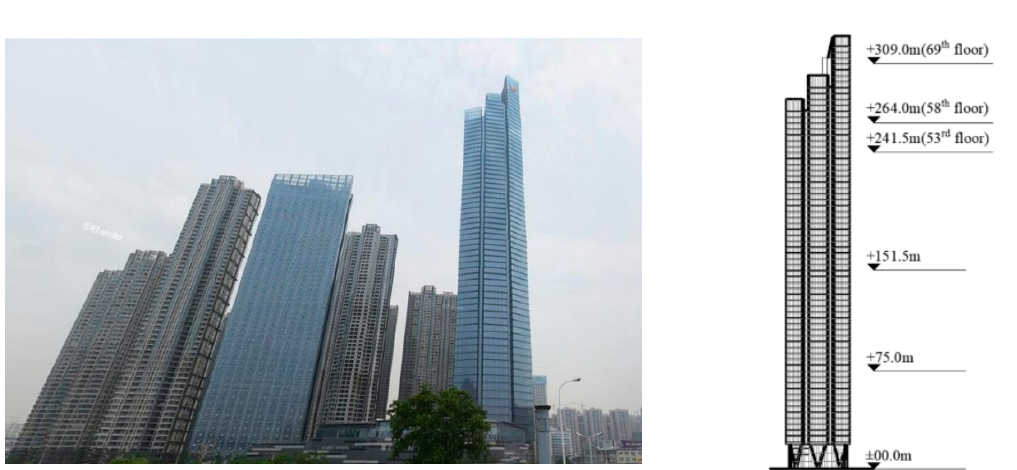
Figure 2. Photograph of the 340 m tall building ( left ) and plan view ( right ).